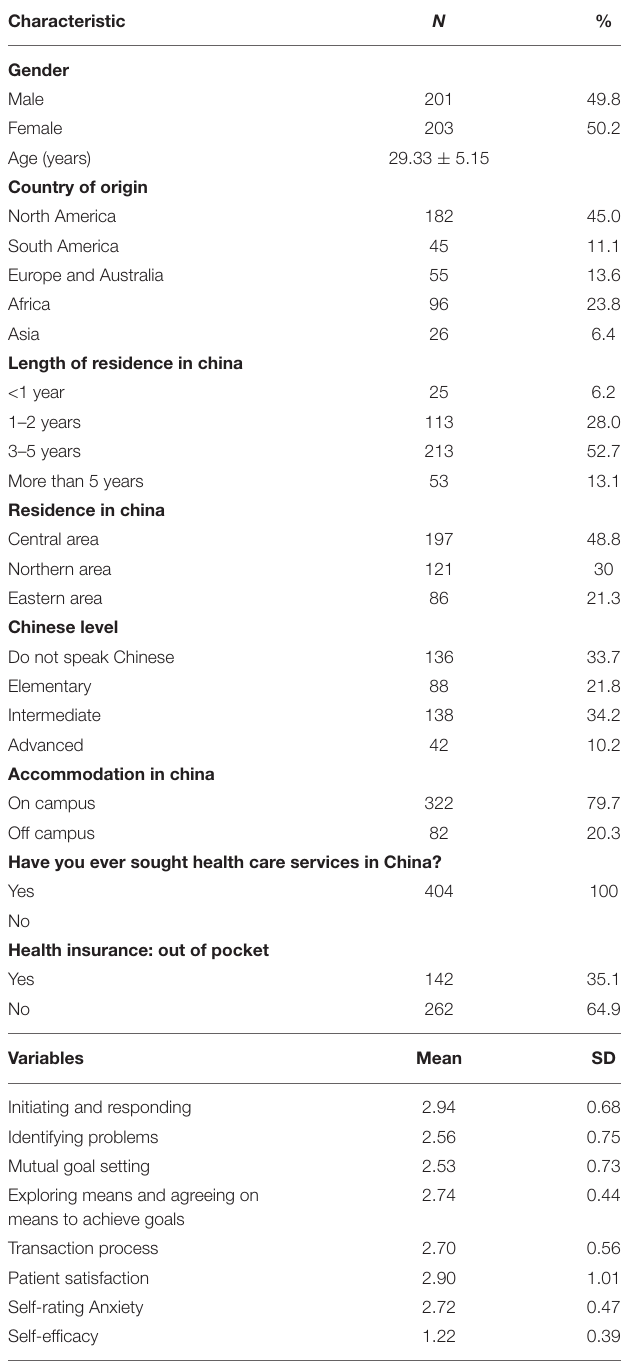
TABLE 1 | Demographic Characteristics of Participants ( N =